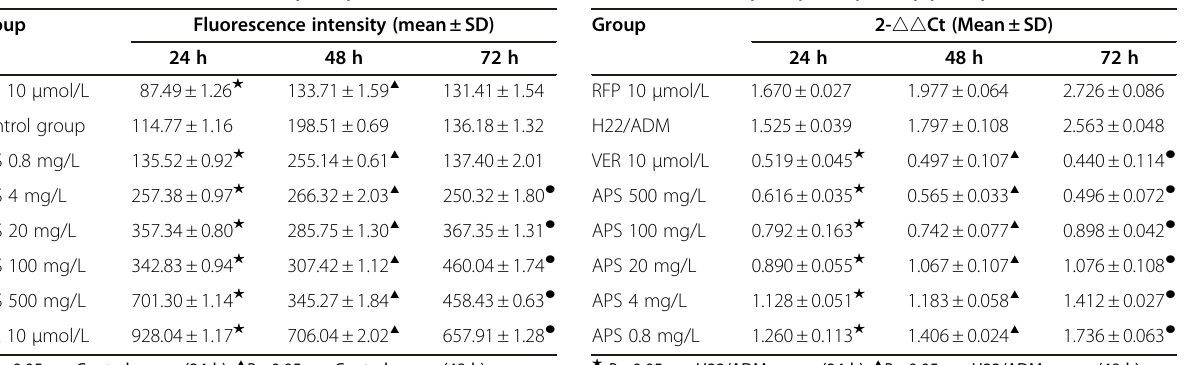
Table 3 MDR1 mRNA expression in H22/ADM cells at Table 2 Intracellular fluorescence intensity of Rh-123